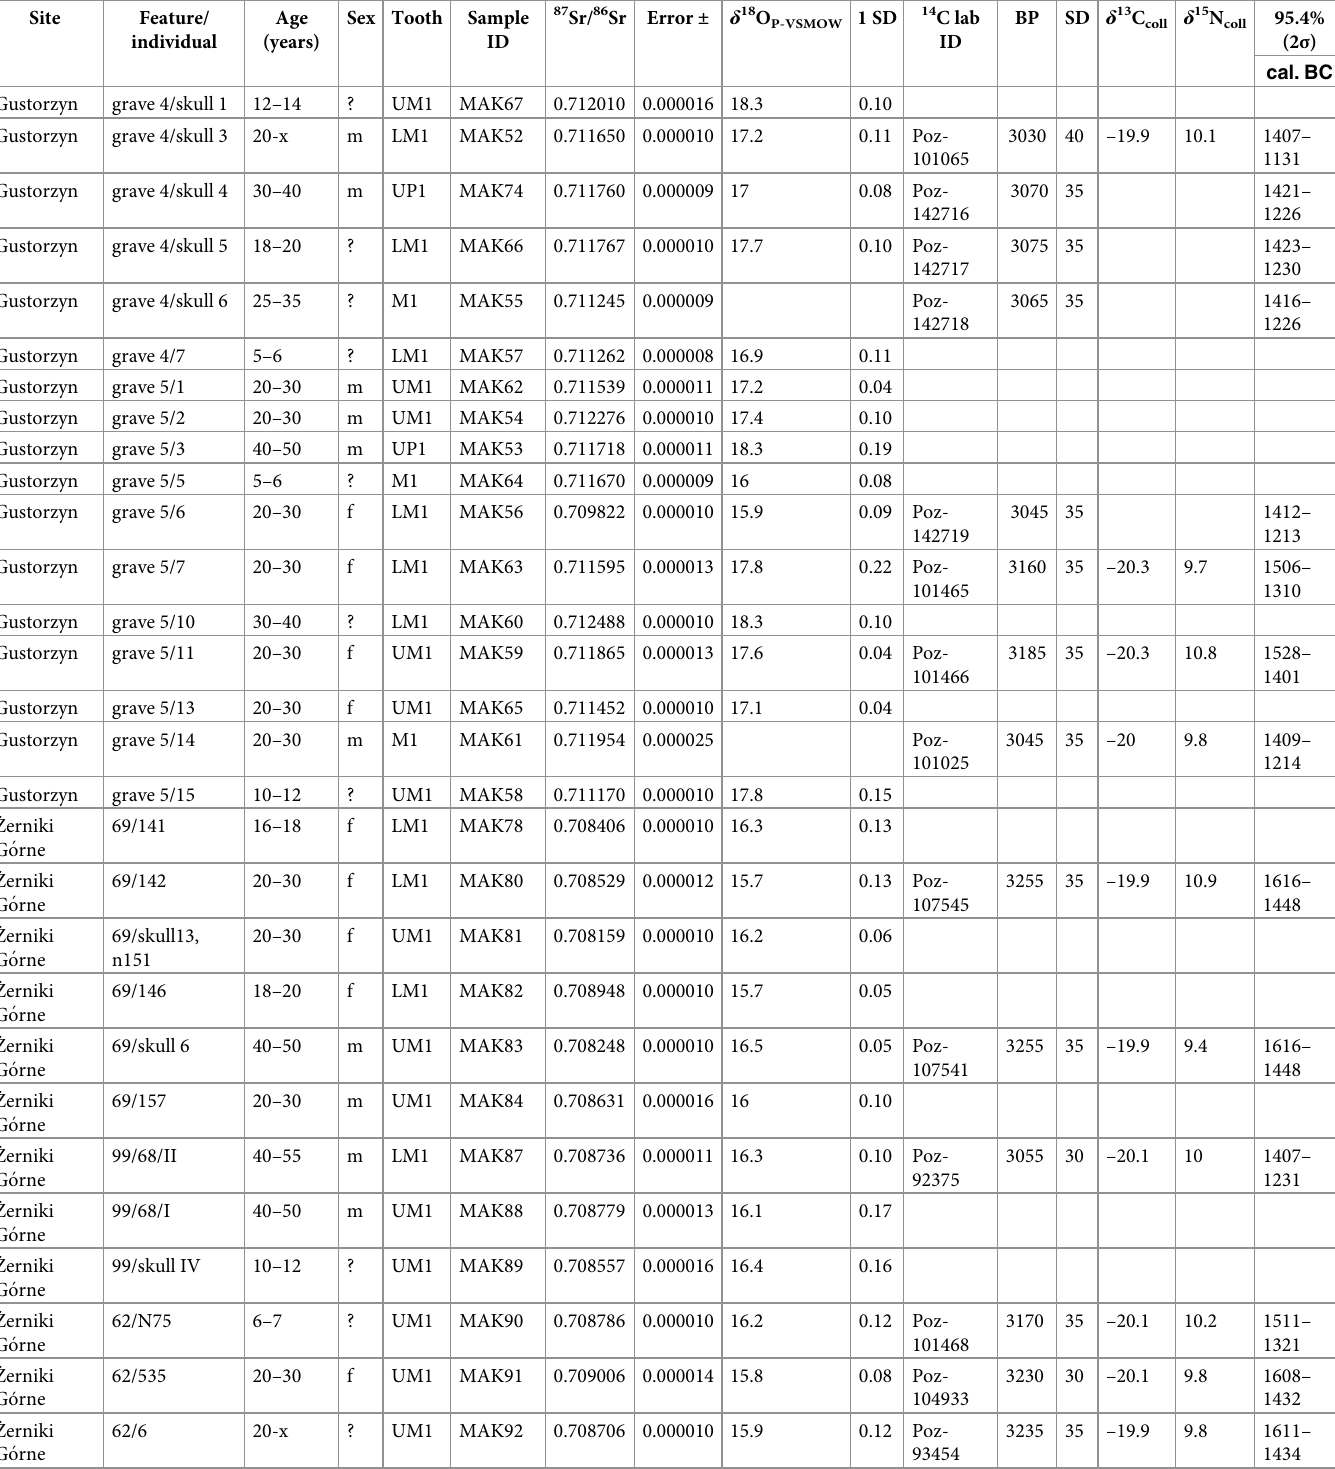
Table 1. Detailed context information, strontium ( 87 Sr/ 86 Sr) and oxygen ( δ 18 O P-VSMOW ) isotope data, AMS radiocarbon ages and bone bulk collagen carbon ( δ 13 C) and nitrogen ( δ 15 N) isotopic data for humans from cemeteries in Gustorzyn and Ż erniki Go´rne. Anthropological data for Gustorzyn after [48, 56]. All 14 C dates were calibrated with OxCal 4.4 [123] using the IntCal 2020 curve